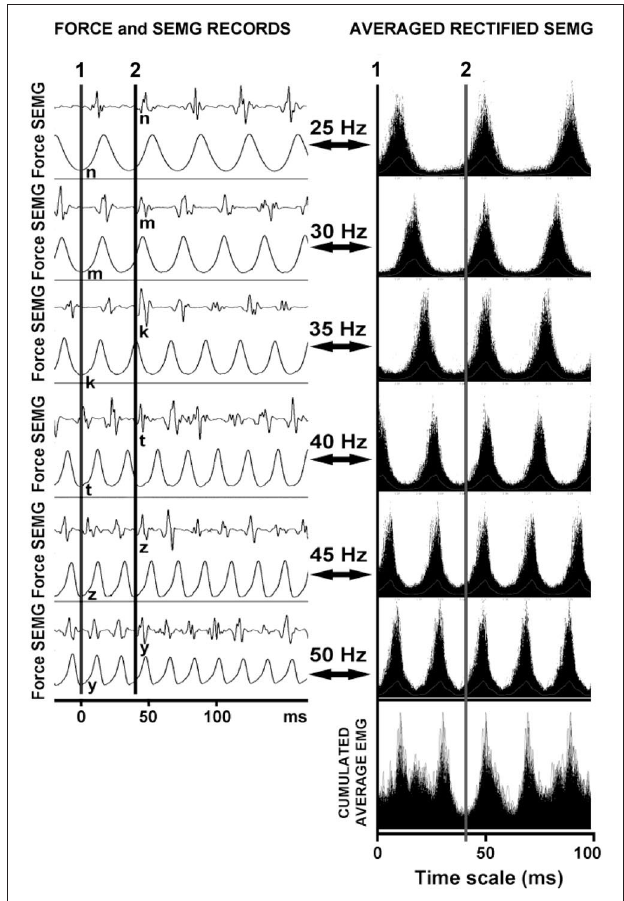
FIGURE 4 | The reflex latencies for different frequencies of WBV and the logic underlying the cumulated average method. The line 1 represents the position of the effective stimulus point and the line 2 represents the reflex latency of the system to that stimulus. Note that the reflex responses are lined up even though the WBV frequencies were